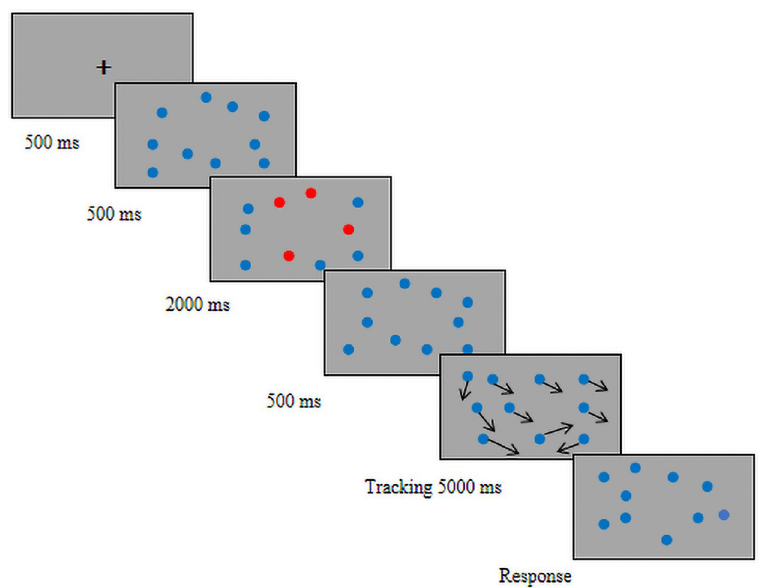
Fig 1. Schematic diagram of the multiple object tracking task. Ten identical blue objects are presented, and four target objects turn red for 2000 ms before turning back to blue. After 1500 ms, all objects move at a speed of 5˚/s for 5000 ms. At the end of the tracking period, the objects stop moving, and participants select the four targets by clicking on each one using the left mouse button.